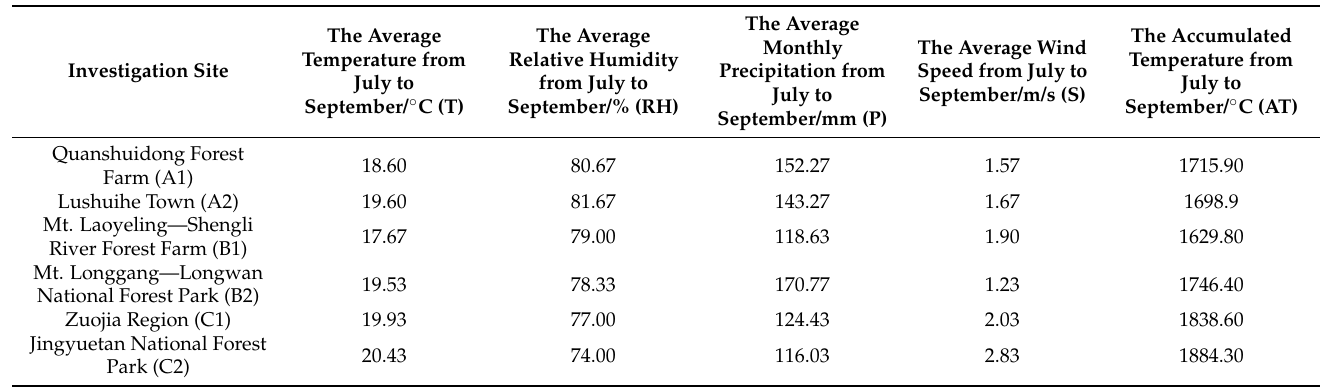
Table 2. Meteorological conditions and types of soil at the investigation